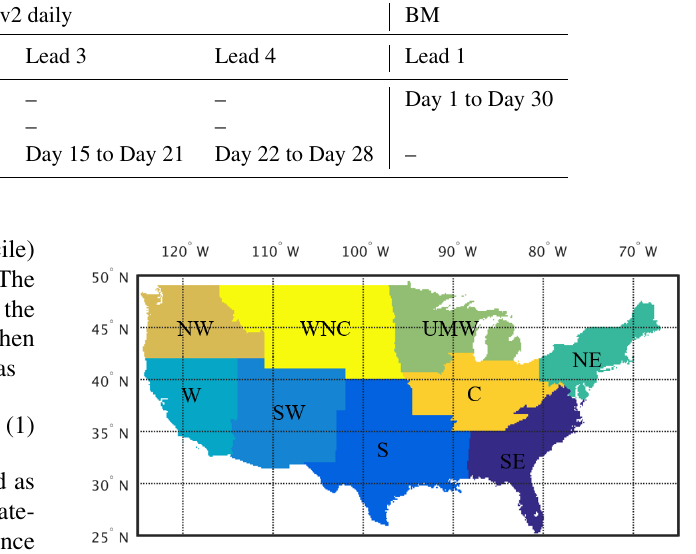
Figure 2. NCEI climate regions (described in Sect. 2) used as areal averaging domains for raw and BM downscaled CFSv2 forecasts. Regions are named as follows: Northwest (NW), West (W), South- west (SW), West North Central (WNC), South (S), Upper Midwest (UMW), Central (C), Southeast (SE), and Northeast